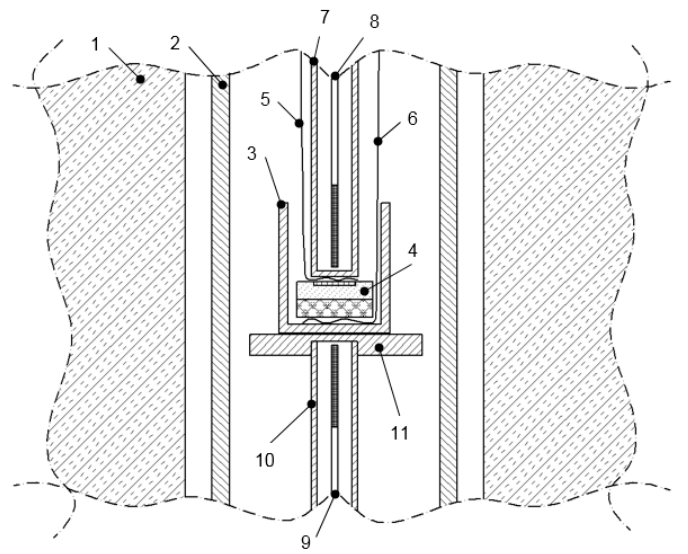
Figure 5. Schematics of the electrochemical setup; 1—vertical resistance furnace, 2—fused silica wok tube, 3—alumina crucible, 4—galvanic cell, 5—Pt anode lead wire, 6—Pt cathode lead wire, 7—upper alumina tube, 8 and 9—Pt100 resistance thermometers, 10—lower alumina tube, 11—alumina disc.